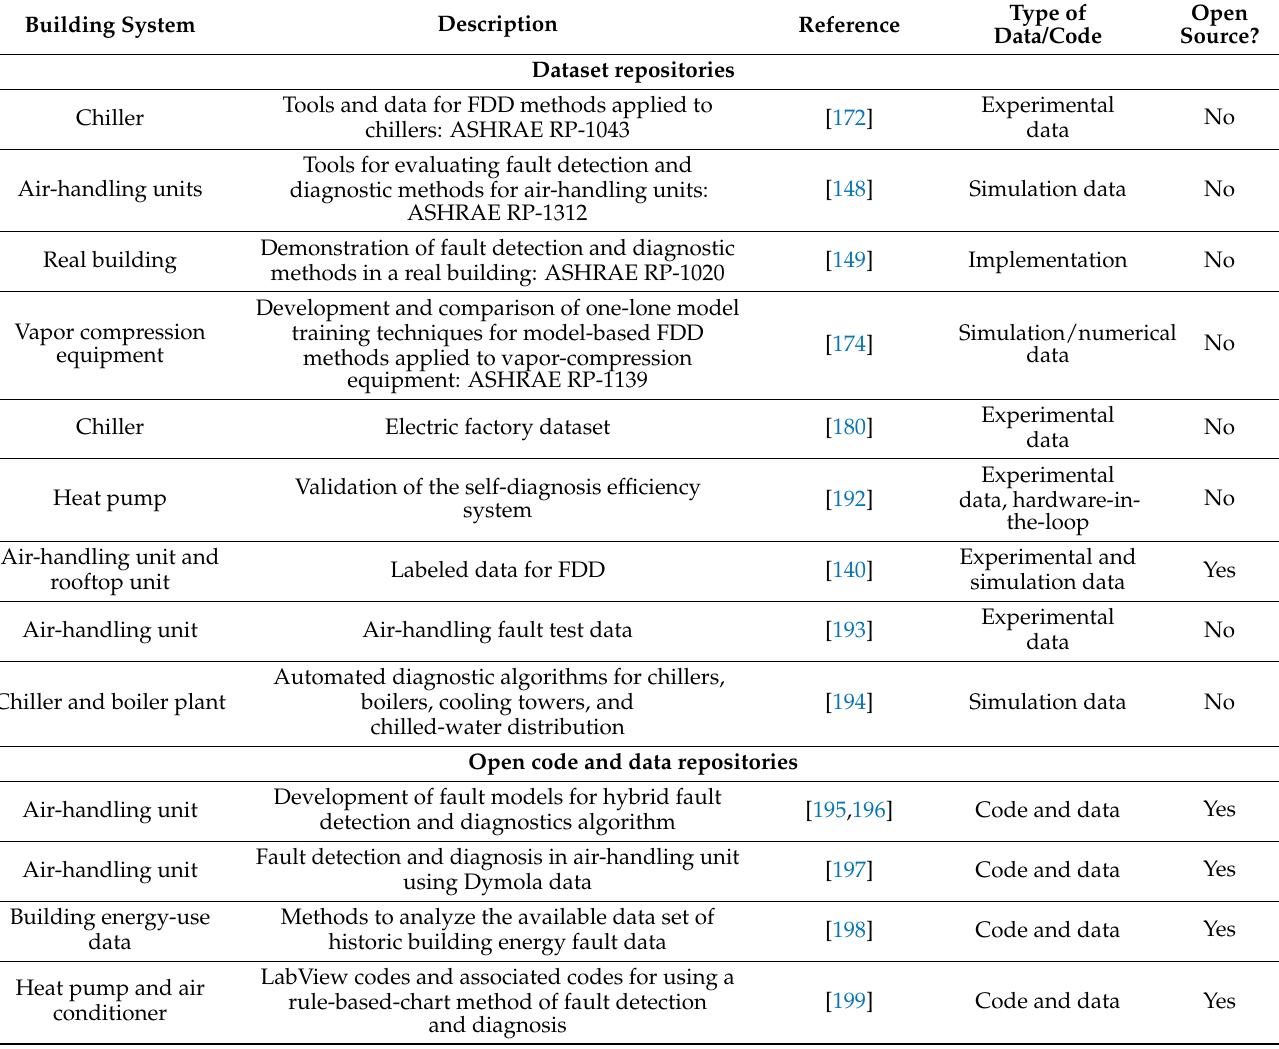
Table 12. The current dataset repositories sorted based on the building system, type of data/code, and whether the dataset was open source. “Experimental data” and “Simulation data” were defined as the following: experimental data comprised a fault dataset created and emulated in a laboratory; simulation data comprised a fault dataset created and emulated in a simulation